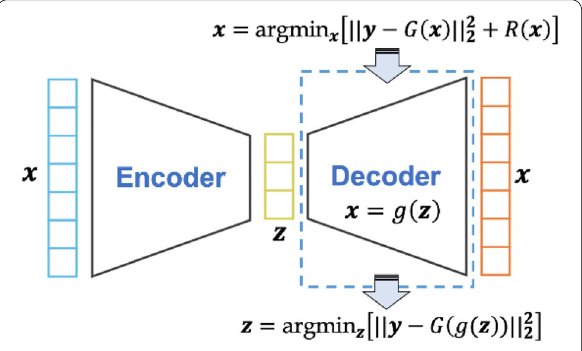
Figure 5 Generative prior for simplification of Eq.